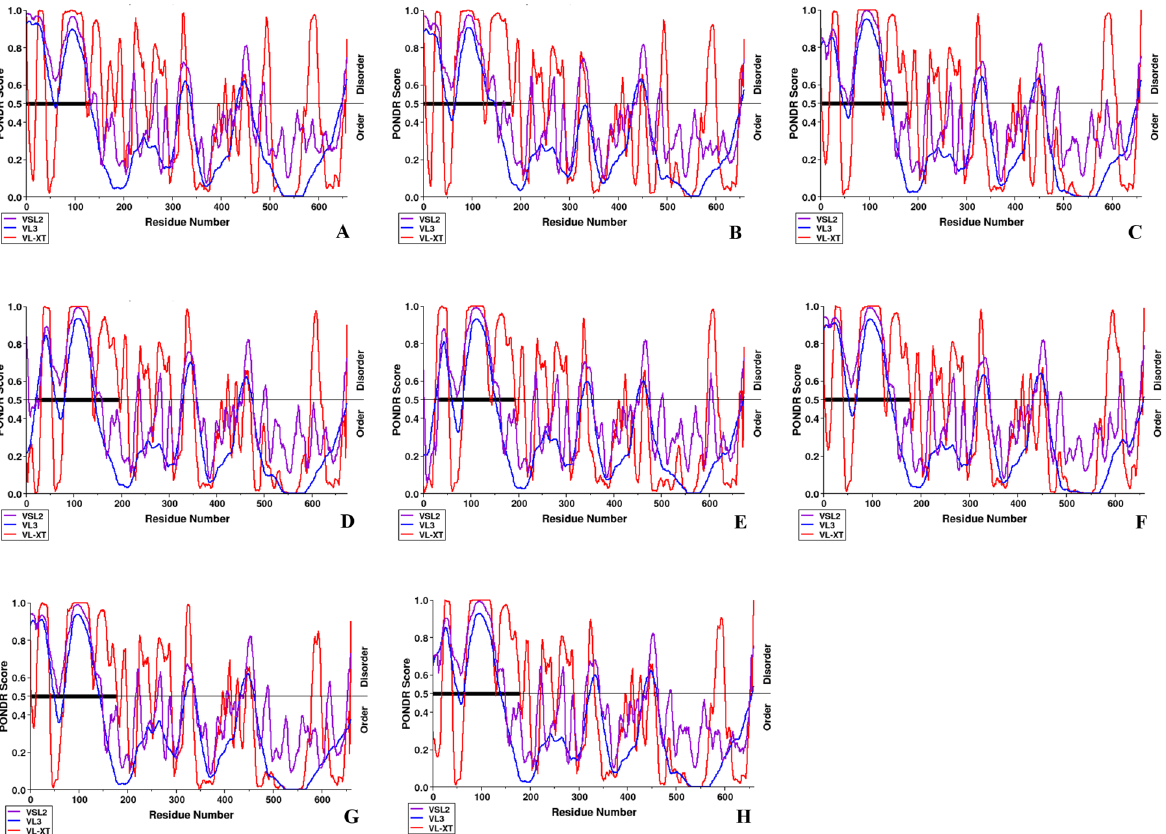
Fig. 3 Analysis of intrinsic disorder predisposition of HEV ORF2. A JF443720 (GT 1); B M74506 (GT 2); C AB222182 (GT 3); D GU119961 (GT 4); E AB573435 (GT 5); F AB602441 (GT 6); KJ496143 (GT 7); and H KX387865 (GT 8). Graphs A – H represent the intrinsic disorder profiles of ORF2 sequences of HEV. Disorder probability was calculated using three members of the family PONDR (Prediction of Natural Disordered Regions), i.e., VLXT, VL3, and VSL2. A threshold value of 0.5 was set to distinguish between ordered and disordered region along the genome (line). Regions above the threshold are predicted to be